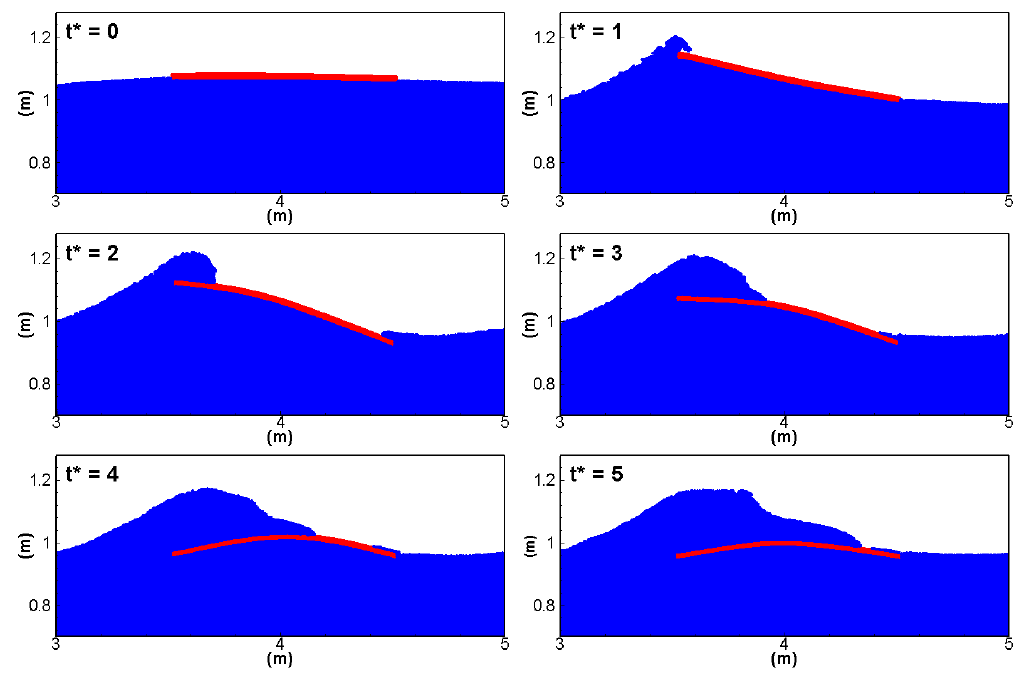
Figure 8. Dynamics of the floating plate with Young modulus E = 250 MPa under severe wave conditions with wave steepness ka = 0.5. Ratio of the plate length to the wavelength is 2 L / λ = 0.43.